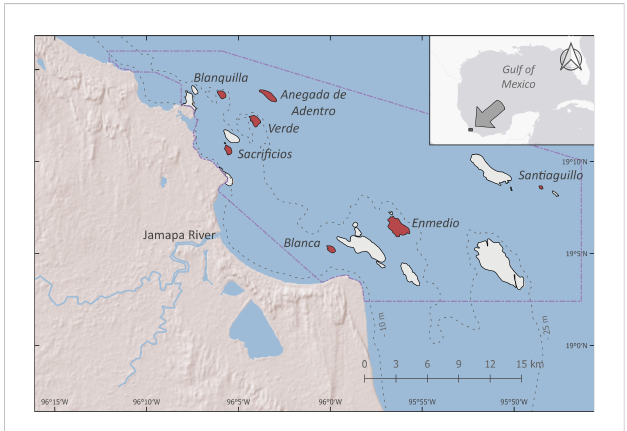
FIGURE 1 Reef surveyed (highlighted in red) inside the Veracruz Reef System National Park (PNSAV) between 2006 and 2021. Dashed lines delimit seascape regions, Inner Shelf (IS) between 10 m and 25 m isobathic contour and Outer Shelf (OS) include waters free from the shelf and when depths > 25 m up to the limit of the continental shelf. Santiaguillo and Blanca reefs are situated inside the PNSAV core